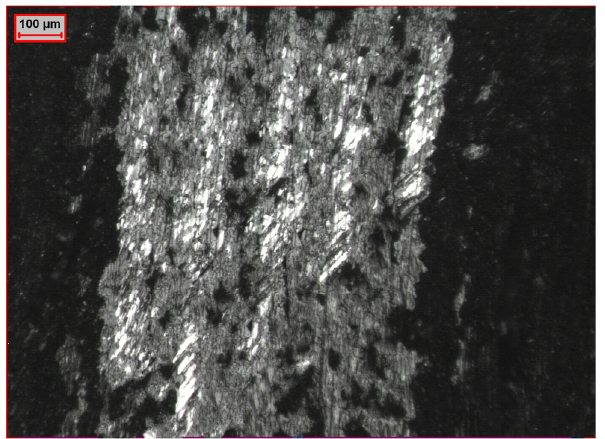
Fig. 15 Optical micrograph of worn track of CpC15 showing sliding wear and insignificant scratches caused by mild abrasion.